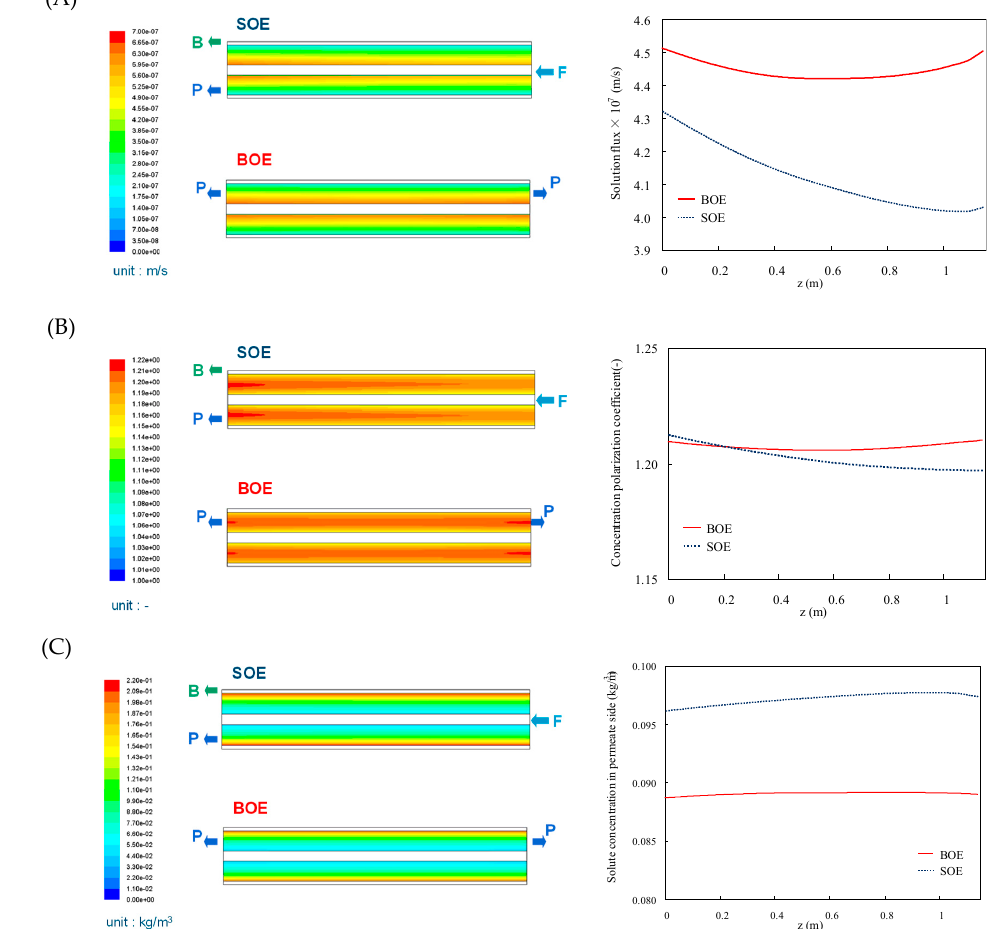
Figure 9. Simulated results by CFD/FCP model. ( A ) Volumetric permeate flux; ( B ) concentration polarization coefficient; ( C ) solute concentration inside the HF and those along the axial ( z ) direction.